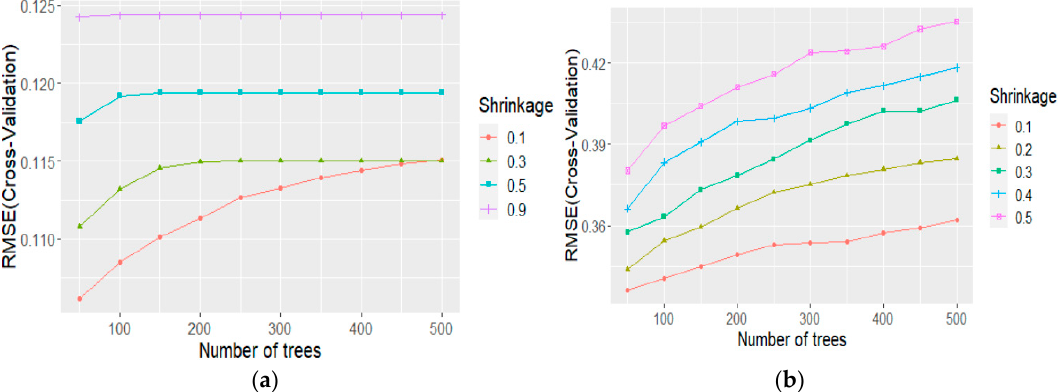
Figure 5. ( a ) Effect of various parameters on XGBoost model ( b ) Effect of various parameters on GBM